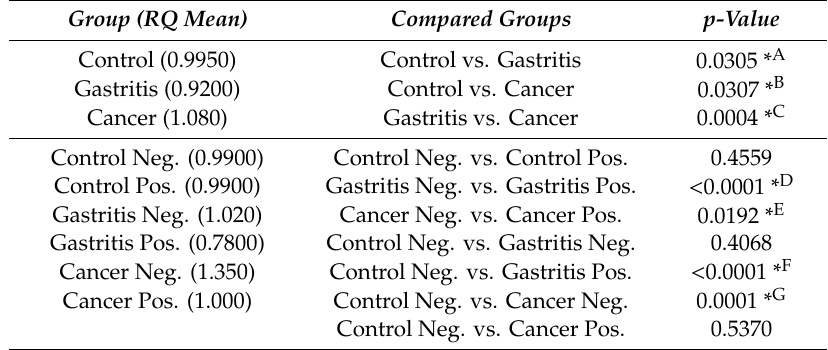
Table 3. RQ mean for the groups considered in miR-106b-5p mRNA expression and p-value results for comparison between the groups.